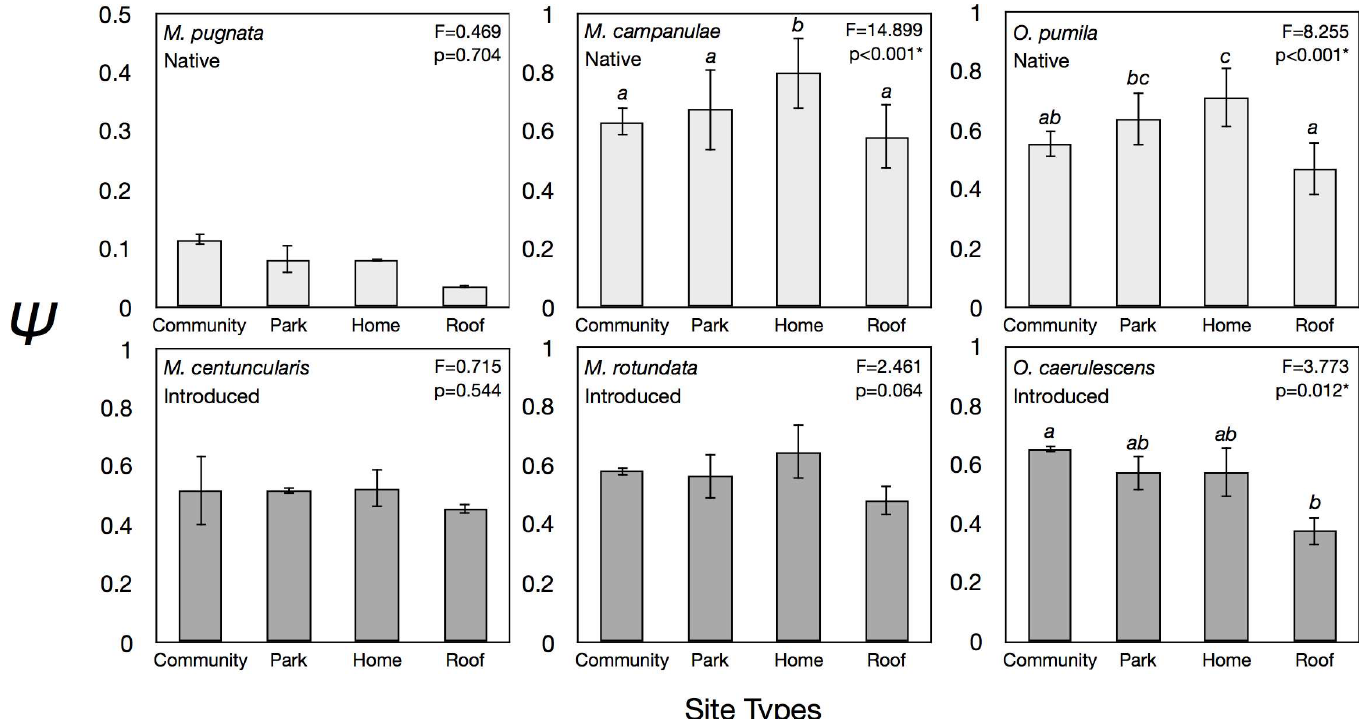
Fig 3. Mean occupancy probabilities of native and introduced bee species when grouped by site using the model equation Ψ (site), p (.). Community gardens(N = 14), buildingrooftops (N = 20), city parks (N = 43), and home gardens(N =